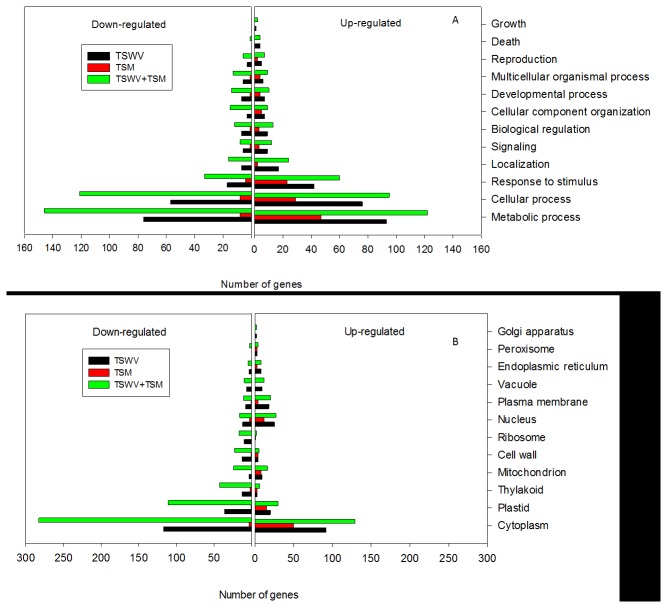
Gene ontology (GO) terms for differentially-expressed genes.Distribution of differentially-expressed genes in tomato plants systemically-infected with TSWV and/or infested with TSM. (A) Biological Process, (B) Cellular Component.